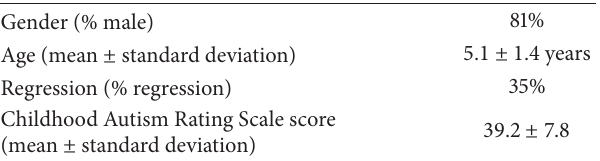
Table 1: Characteristics of the 37 participants with autistic disorder who completed the